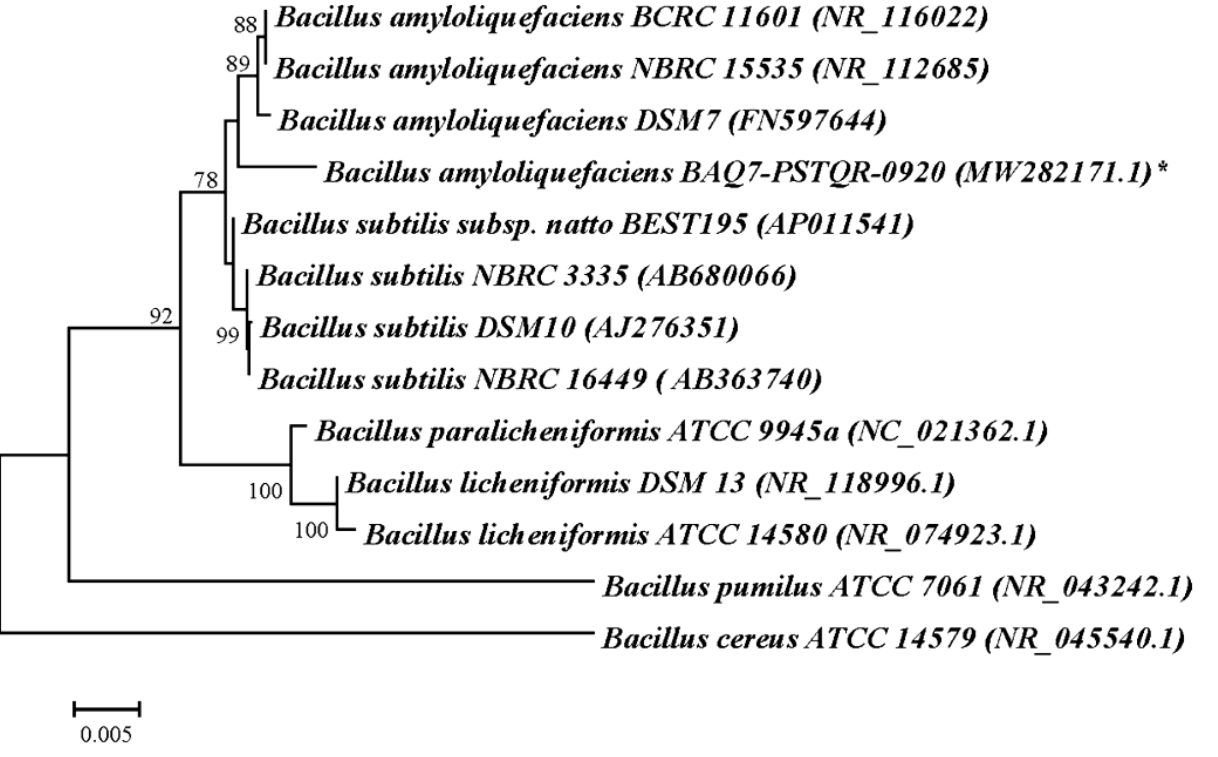
Figure 1. The dendrogram of the genetic similarity between strain BAQ7-PSTQR-0920 and various representatives of the Bacillus genus constructed on the basis of 16S rRNA gene sequences using the Neighbor-Joining method and Kimura’s 2-parameter model. The scale bar indicates 0.005 substitutions per nucleotide position. The analyzed strain is indicated by *.